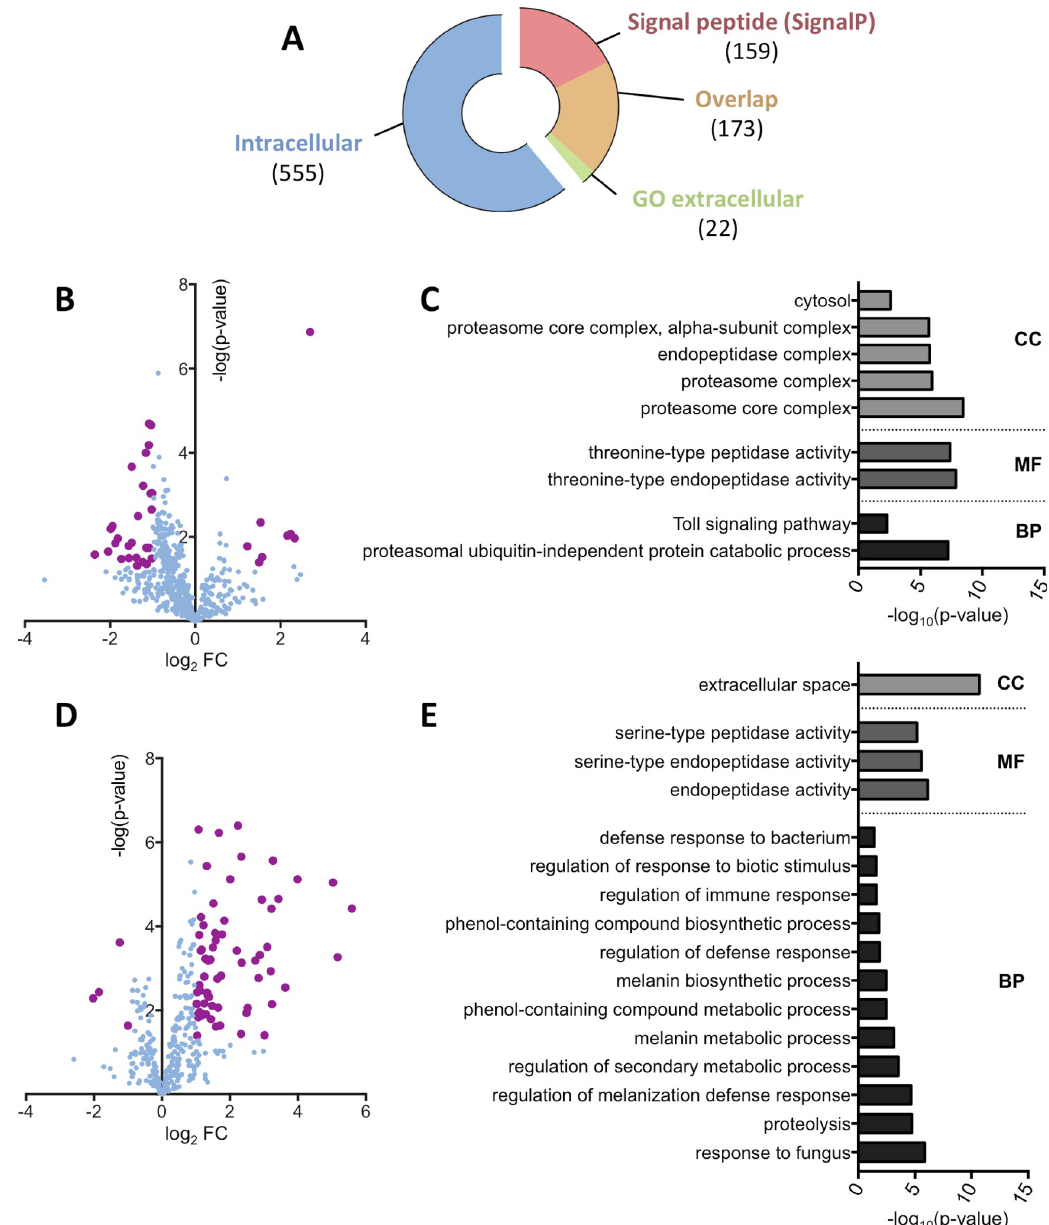
Fig 1. Drosophila hemolymph protein profiling upon Spiroplasma infection. (A) Representation of the dataset repartition between intracellular and extracellular protein groups. Extracellular groups are detected either by the presence of a predicted signal peptide using the SignalP algorithm or the annotation with a GO term referring to the extracellular space. The overlap category corresponds to protein groups with both a predicted signal peptide and a GO term “extracellular”. Numbers in brackets indicate the number of protein groups in each category. (B) Volcano plot of the intracellular protein group subset. The log 2 fold- change indicates the differential representation of the protein group in the infected samples versus the uninfected samples. Bold purple dots indicate significance as defined by an absolute fold change value over 2 or under -2 and a p-value below 0.05. (C) Functional GO annotation of the intracellular protein groups. Only significant (p-value < 0.05) GO terms of hierarchy 4 or less are displayed. CC: Cell Component; MF: Molecular Function; BP: Biological Process. (D) Volcano plot of the extracellular protein group subset. The log 2 fold-change indicates the differential representation of the protein group in the infected samples versus the uninfected samples. Bold purple dots indicate significance as defined by an absolute fold change value over 2 or under -2 and a p- value below 0.05. (E) Functional GO annotation of the extracellular protein groups. Only significant (p-value < 0.05) GO terms of hierarchy 4 or less are displayed. CC: Cell Component; MF: Molecular Function; BP: Biological Process.